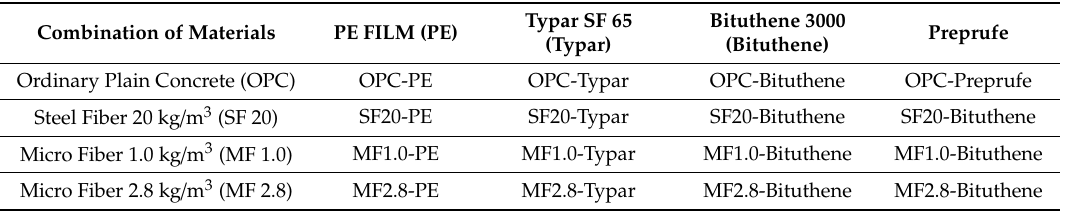
Table 3. Composition of test specimens from protective waterproof materials.